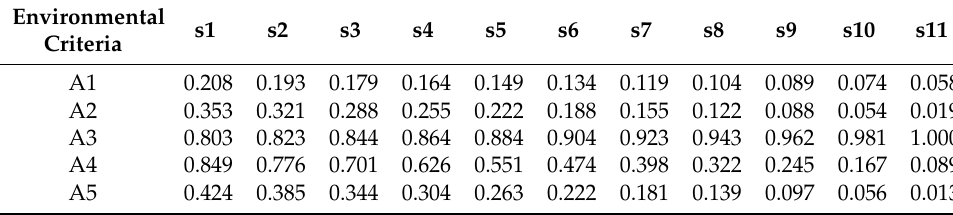
Table 11. New criteria weights for environmental